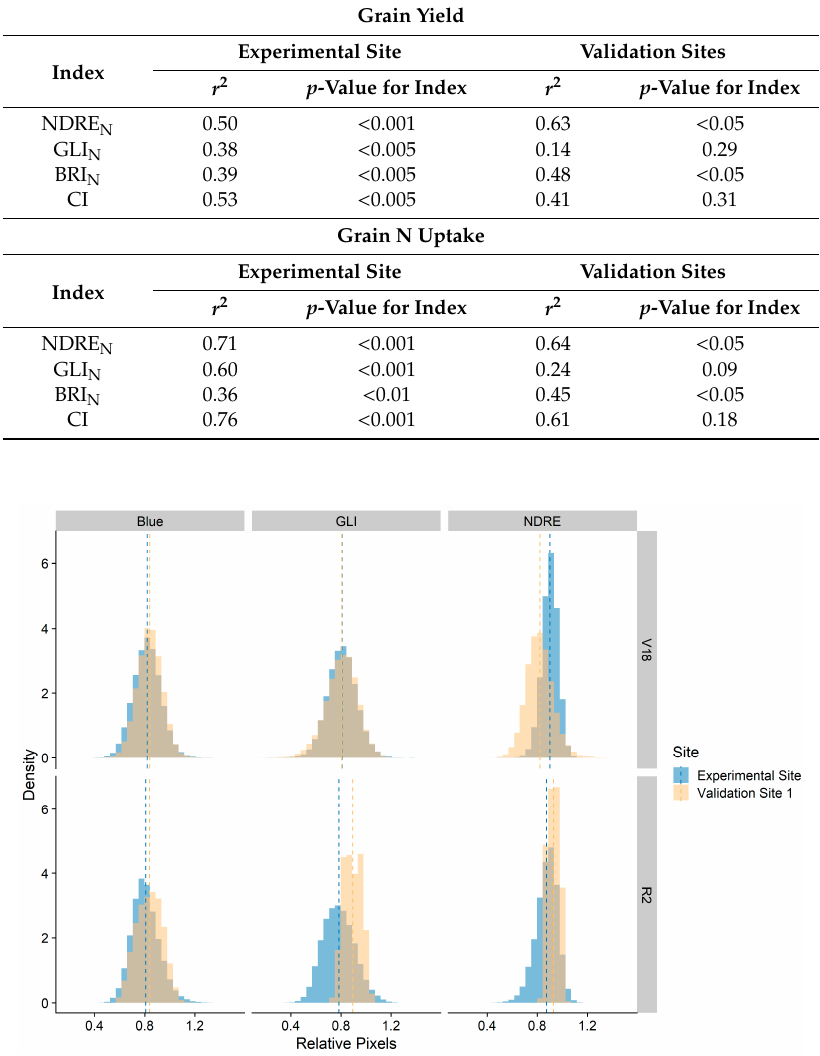
Table 7. Compares the linear relationships between the vegetation indices normalized green leaf index (GLI N ), blue reflectance index (BRI N ), and normalized di ff erence red-edge (NDRE N ) and resulting combined index (CI) measured at blister (R2) and the grain yield or nitrogen uptake at the experimental site using Equation (9) and the validation sites using Equation (10). r 2 = coe ffi cient of determination